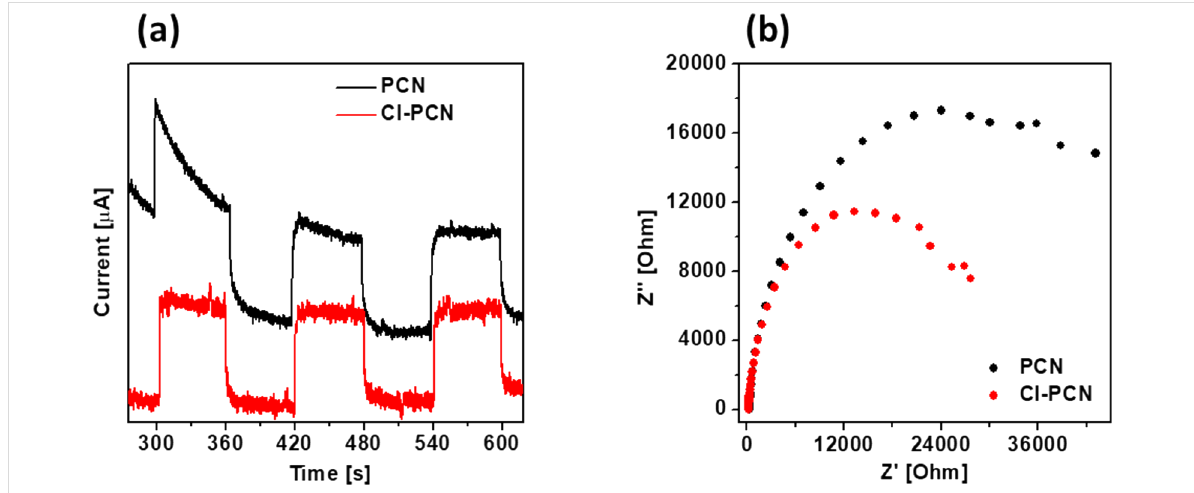
Figure 9: (a) Photocurrent response and (b) EIS spectra of PCN and